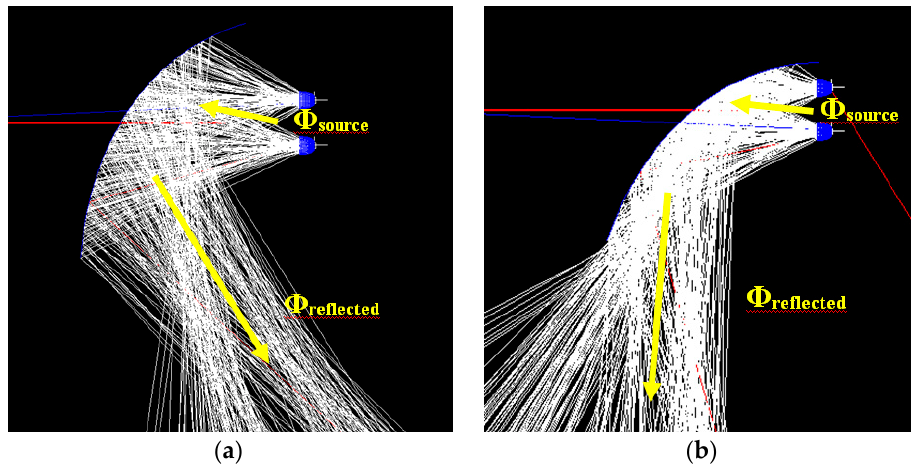
Figure 7. Image of the change of a luminous flux direction for the changed inclination of the reflector relative to the LED light source with focusing lenses: ( a ) minimum inclination, ( b ) maximum inclination.